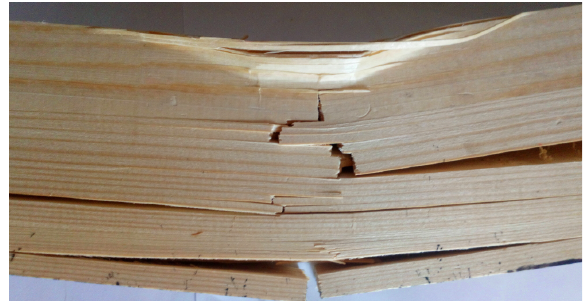
Figure 17. Back face of the beam